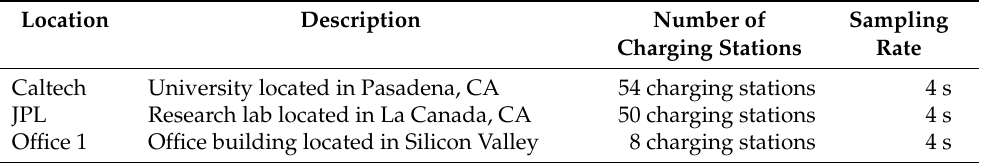
Table 2. Overview of locations where the ACN dataset was